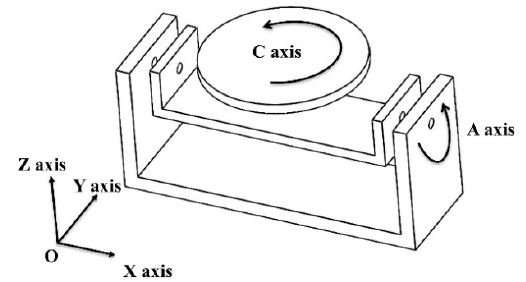
Figure 3. Schematic diagram of the 5-axis material extrusion (MEX) platform structure.